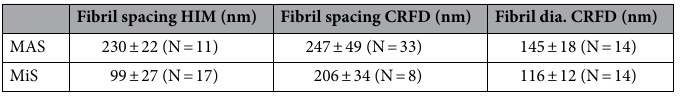
Table 1. The measurements of fibral spacing and